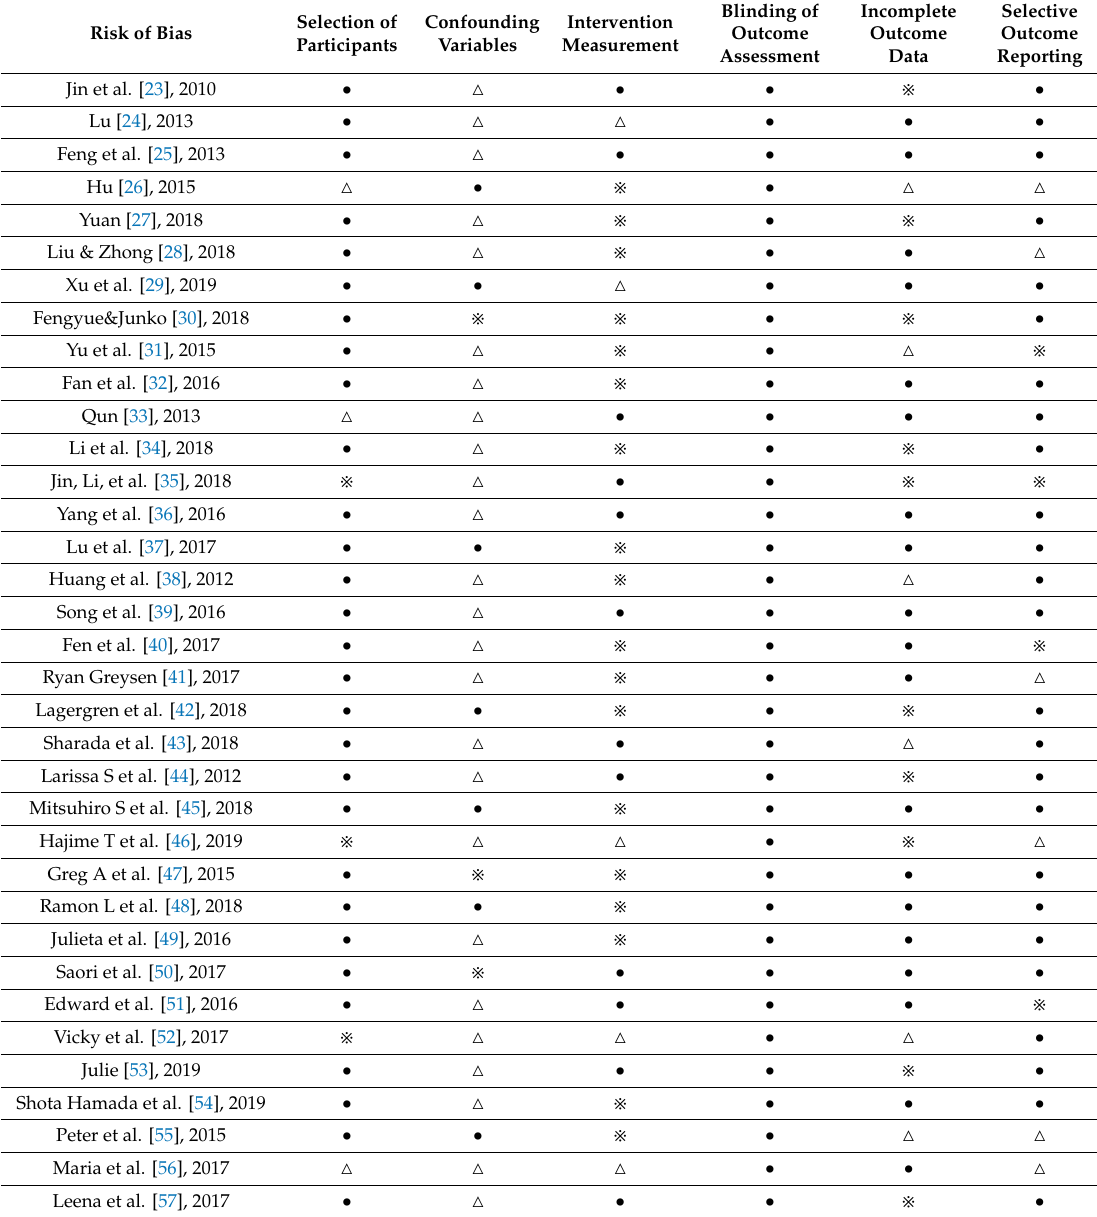
Table 1. Quality of